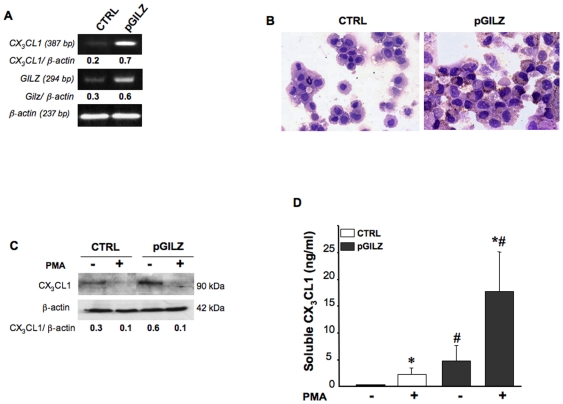

GILZ upregulation increases CX3CL1 levels in ovarian epithelial malignant cells.(A) CX3CL1 PCR signal intensity in CTRL and pGILZ BG-1 cells was quantified by densitometry with normalization against the signal for ß-actin; results are expressed as CX3CL1/ß-actin ratios. One experiment representative out of three. (B) Immunostaining for CX3CL1 on CTRL and pGILZ BG1 cytocentrifuged cells. Magnification x 40. (C) Total cellular protein extracts of CTRL and pGILZ BG1 cells cultured with or without 100 ng/ml PMA for 24 h were analyzed by western blotting with a specific Ab recognizing the extracellular domain of CX3CL1. CX3CL1 levels were quantified by densitometry, with normalization against the signal for ß-actin; results are expressed as CX3CL1/ß-actin ratios. One experiment representative of three. (D) Histograms show the release of sCX3CL1 into the supernatant of cells treated or not with PMA, as measured by ELISA. Results are the means ± SEM of three independent experiments. *P<0.05, absence versus presence of PMA and #
P<0.05, CTRL versus pGILZ BG1 cells (unpaired t test).